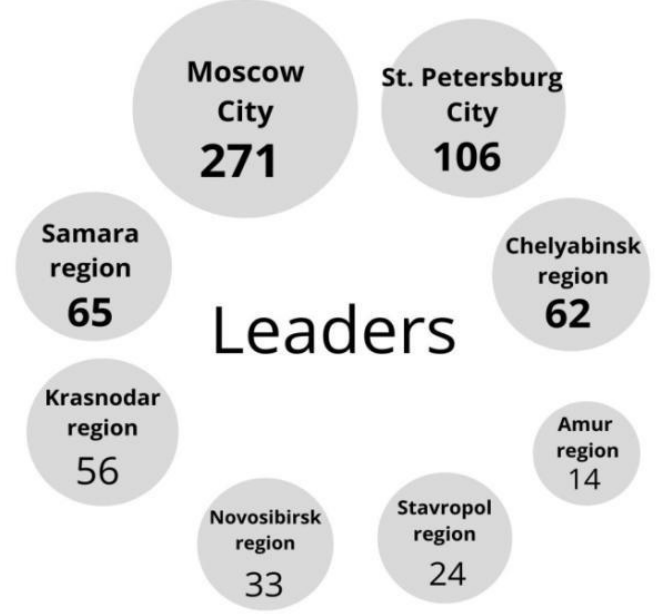
Figure 3. Leading regions in terms of the number of initiatives having federal significance posted by their residents (the leader from each federal district is marked) (number of initiatives and petitions).